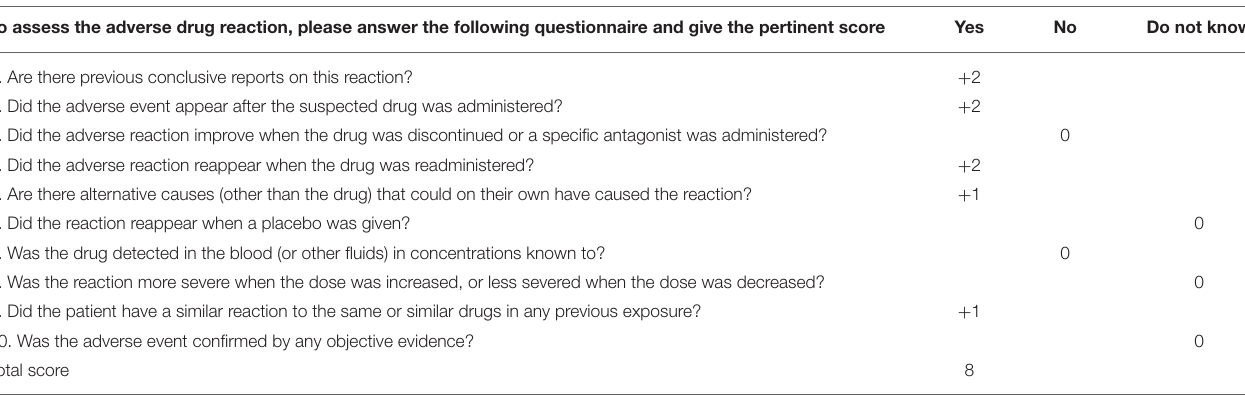
TABLE 2 | The weighted scores of our patient on the Naranjo Scale